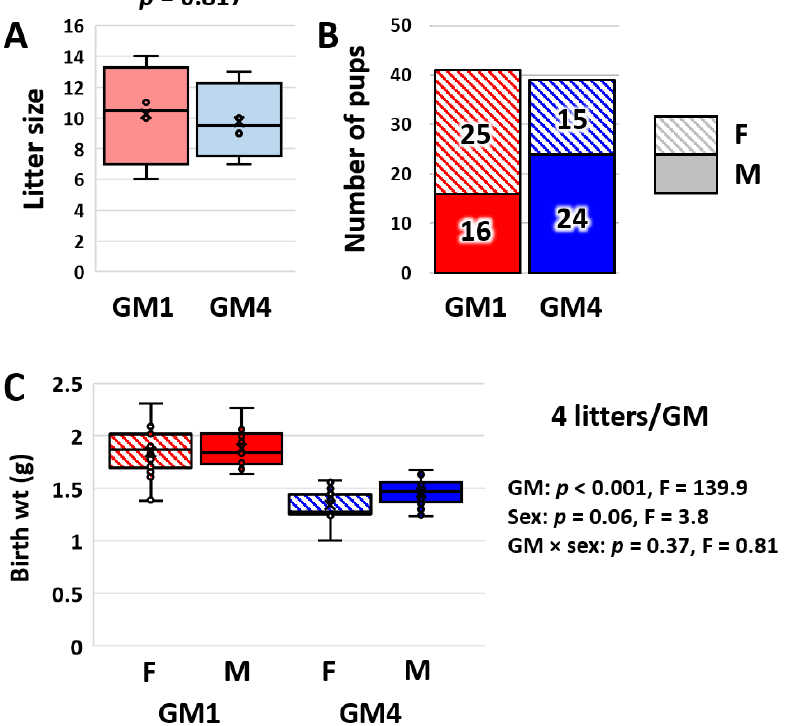
Figure 4. Box and bar plots showing the distribution of litter sizes ( A ) and sexes ( B ) in four litters of roughly equivalent sizes born to dams colonized by GM1 or GM4, and box plot showing birth weights of female (F) and male (M) mouse pups born to GM1- or GM4-colonized dams ( C ). Results of two-way ANOVA on